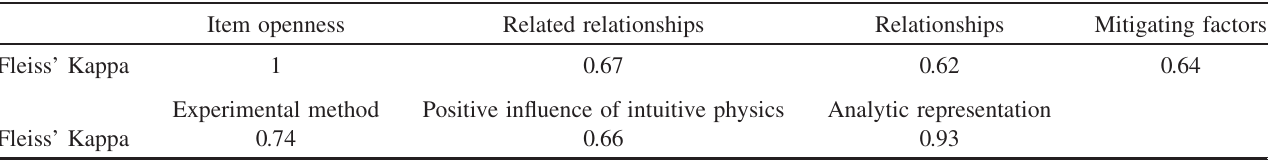
TABLE XI. Intercoder agreement measures for singled-out item difficulty